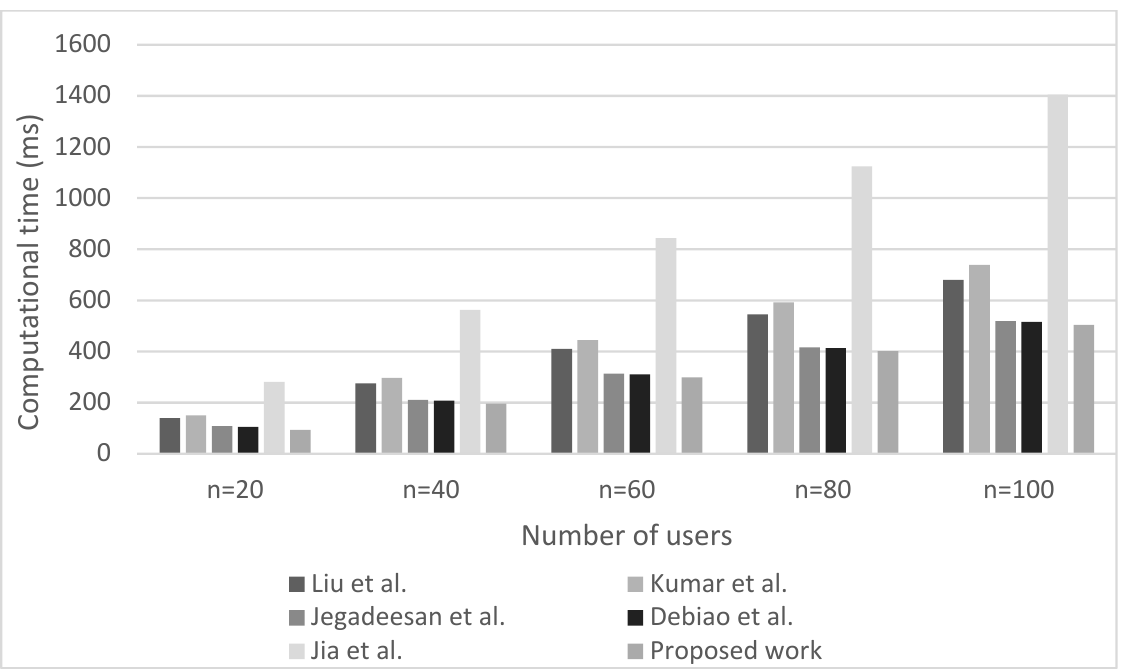
Figure 3. Computation overhead of analyzed authentication schemes at the doctor’s side (Liu at al. [49], Kumar at al. [44], Jegadeesan et al. [50], Debiao et al. [51] and Jia at al. [52]).